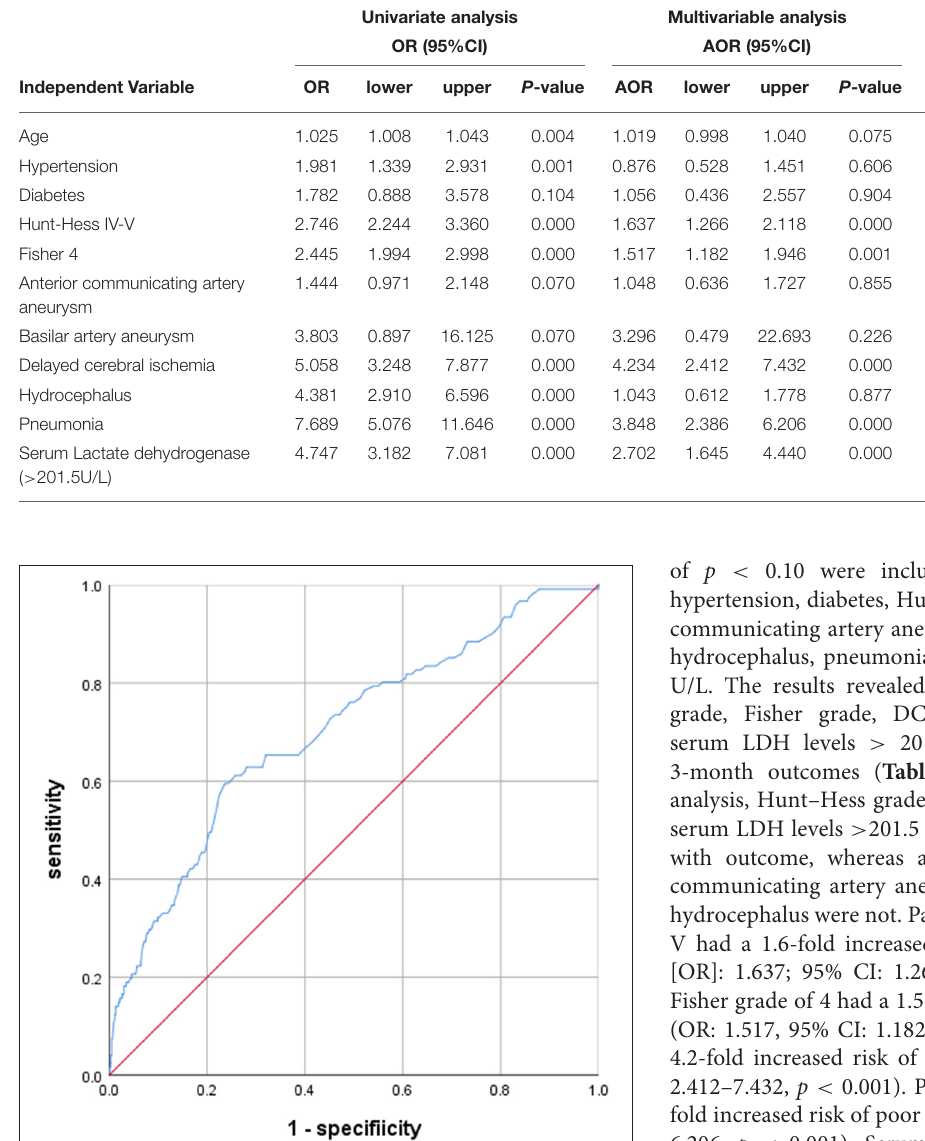
TABLE 2 | Predictors for poor outcome of aSAH in multivariable model.